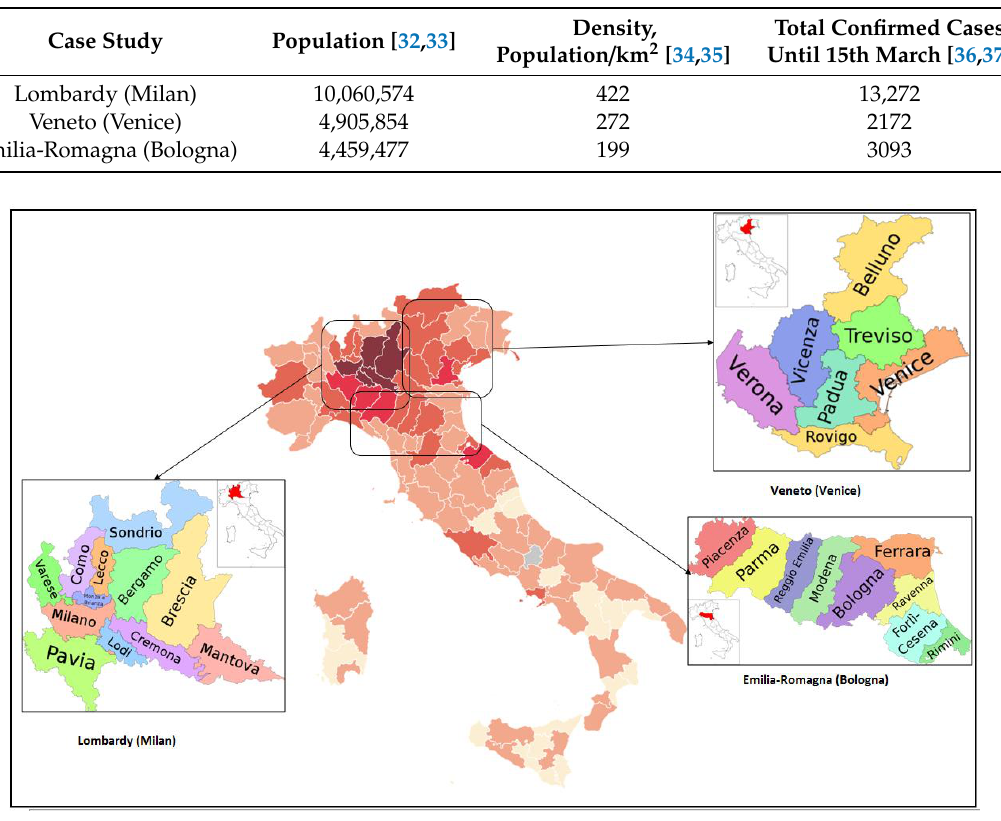
Figure 1. The case studies location, Italy [37–40].